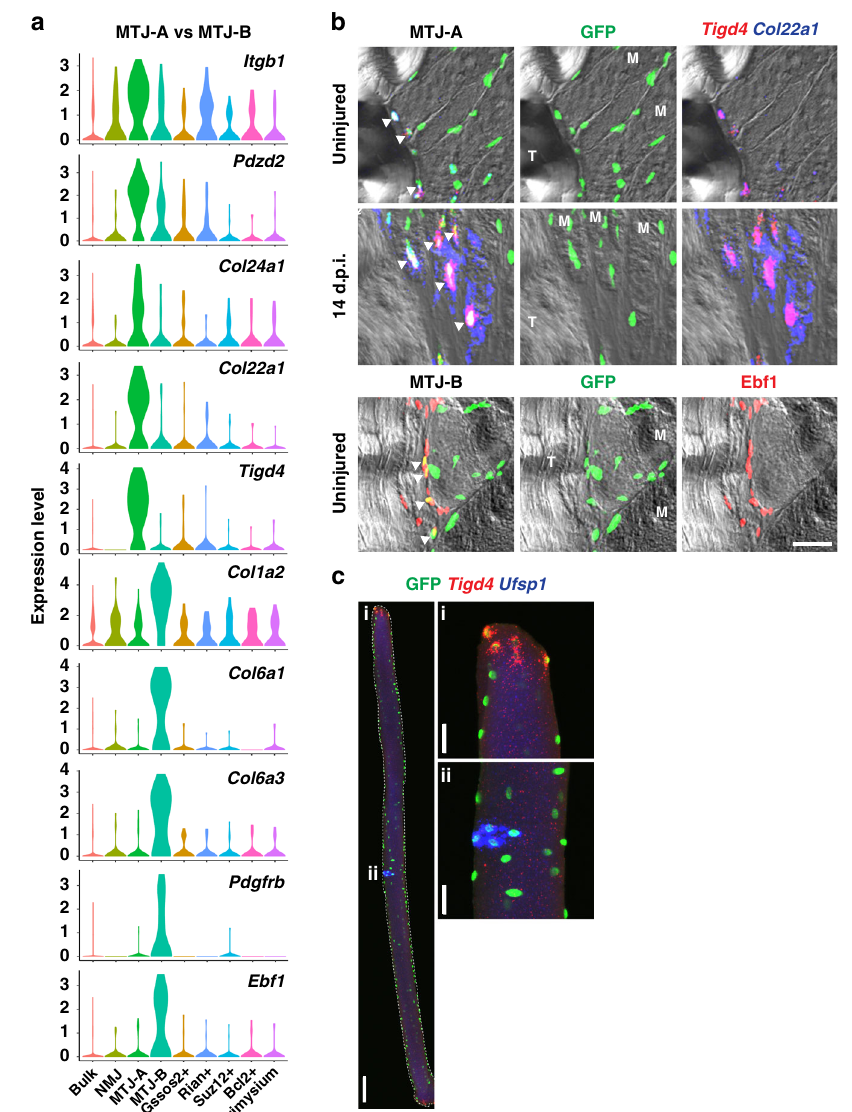
Fig. 2 Two distinct nuclear populations at the myotendinous junction. a Marker genes enriched in MTJ-A or MTJ-B nuclei are presented by violin plots. b Upper two rows — single-molecule FISH of two MTJ-A markers ( Tigd4 and Col22a1 ) in uninjured or 14 d.p.i TA muscle expressing H2B-GFP in myonuclei. Bottom row — Ebf1 (MTJ-B marker) immuno fl ourescence in uninjured TA muscle expressing H2B-GFP in myonuclei. Shown are MTJ regions; T, tendon and M, myo fi ber. Arrowheads indicate co-localization of MTJ marker genes and GFP. Scale bar, 30 µ m. c Conventional FISH experiment in an isolated single EDL fi ber. Insets show magni fi cation of MTJ (i) and NMJ (ii) regions. Scale bars, 100 µ m (for the entire fi ber) and 30 µ m (for the insets). Expression patterns were validated in two or more